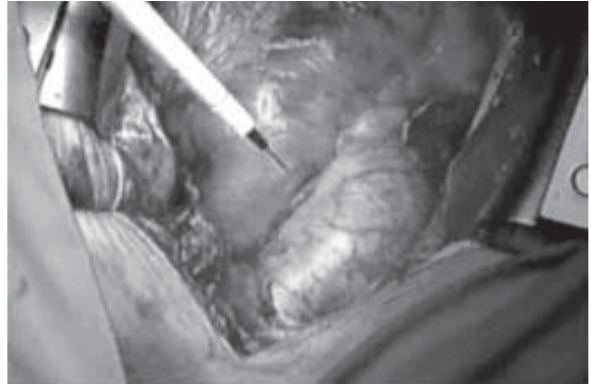
Fig. 3 – Intra-operative photograph exhibiting details of the approach of the aortotomy to the